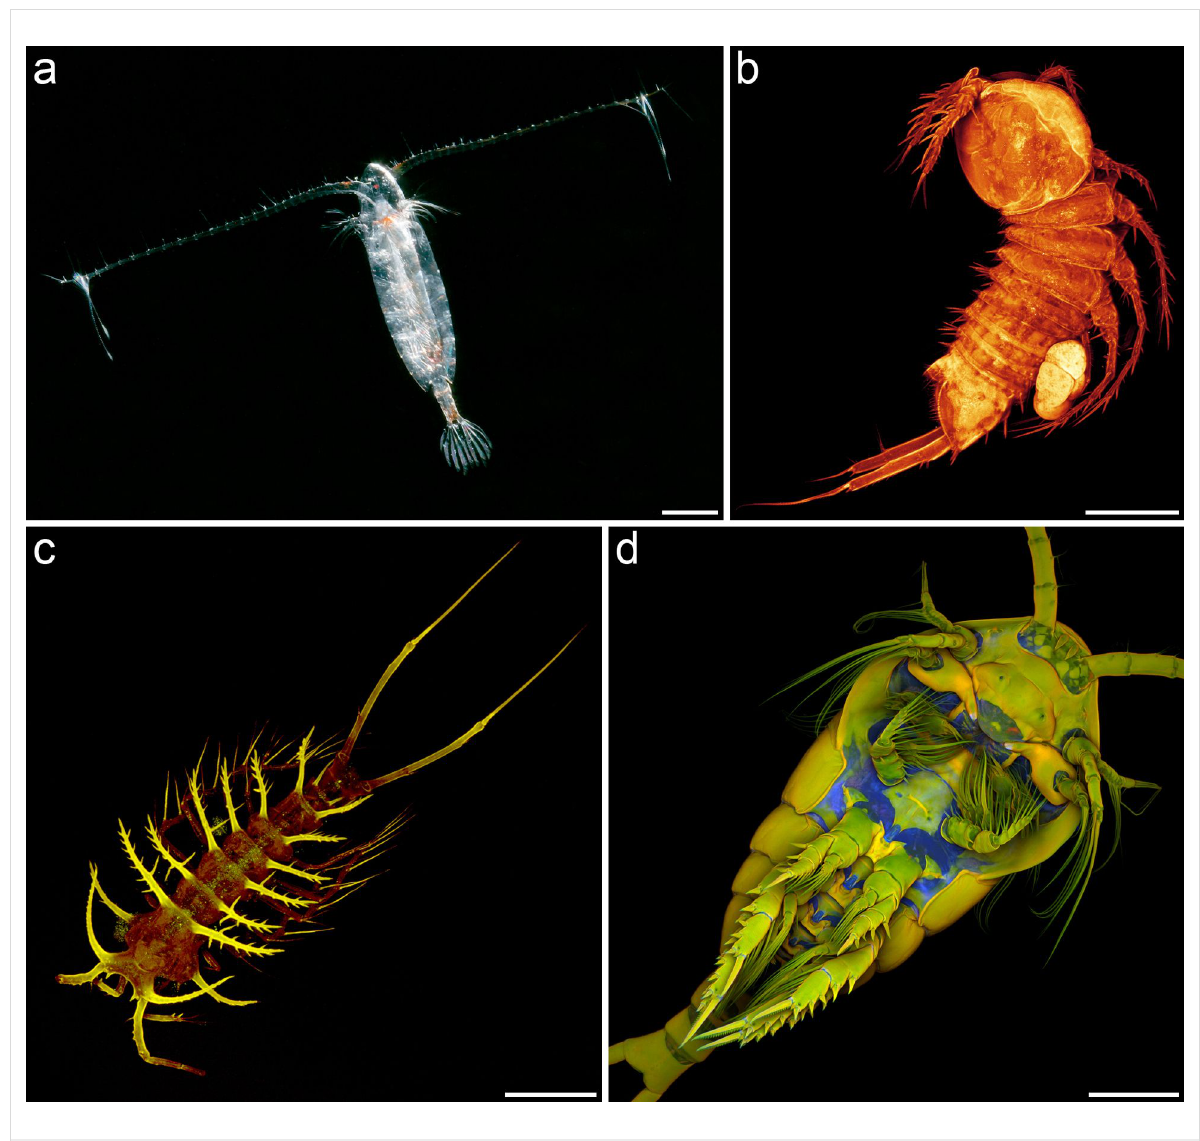
Figure 1: Exemplary copepod species. (a) Female of Calanoides acutus , one of the dominant calanoid copepod species within the zooplankton of the Southern Ocean (dorsal view). (b) Female of the harpacticoid copepod genus Mesocletodes , collected from deep-sea sediment in the Southern Ocean (lateral view). (c) Female of Ceratonotus steiningeri , a harpacticoid deep-sea copepod species, collected from sediment in the Angola Basin at a water depth of 5389 m (dorsal view). (d) Female of the planktonic calanoid copepod species Temora longicornis , collected in the North Sea (ventral view). Scale bars = 1 mm (a), 100 µm (b, c), 200 µm (d). (a) Photograph (courtesy of Ingo Arndt). (b–d) Confocal laser scanning micrographs (maximum intensity projections). (b–d) Adapted with permissions from [9-11]. Copyright 2014 Wiley-VCH Verlag GmbH & Co.